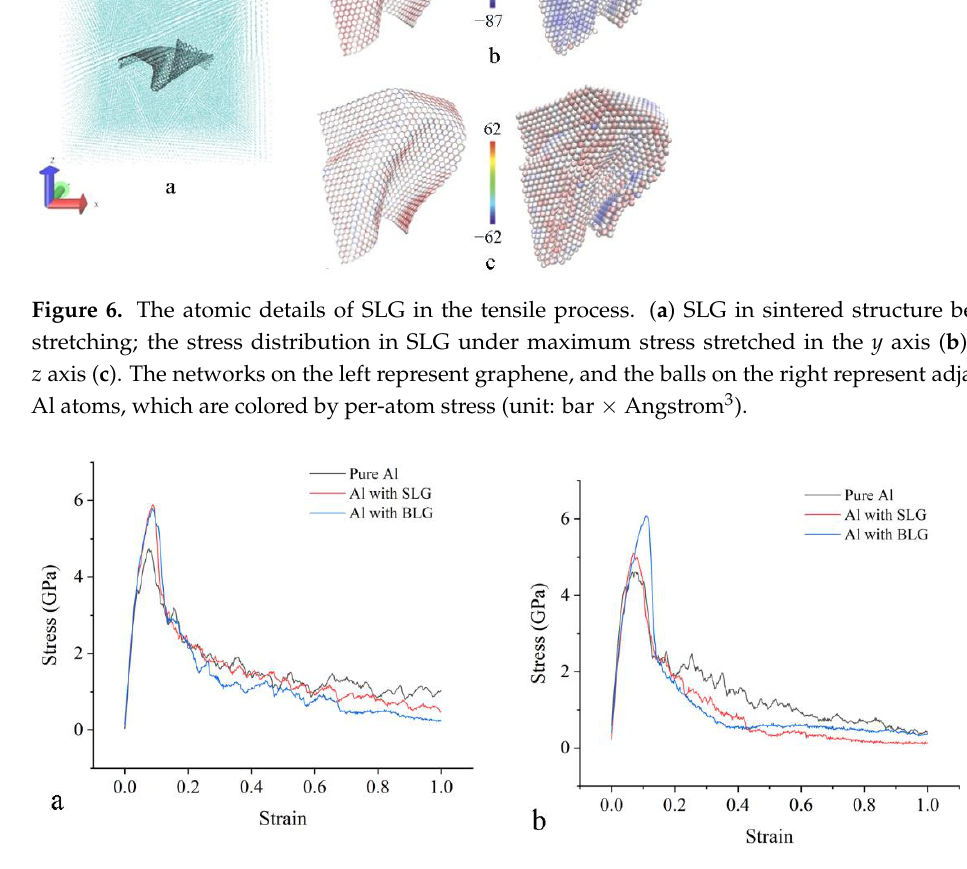
Figure 7. The stress–strain curves in tensile simulations of the sintered models. ( a ) The models are stretched in the y direction; ( b ) the models are stretched in the z direction.